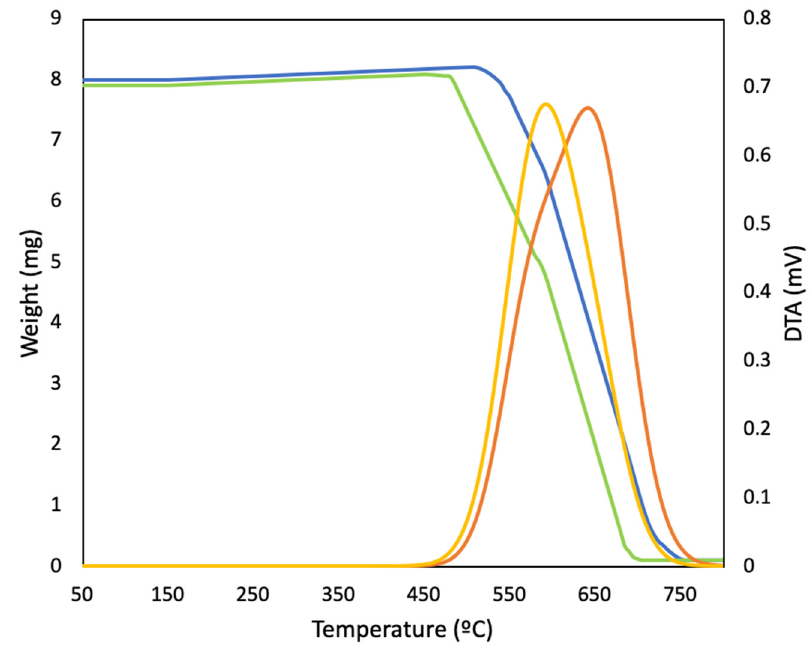
Figure 5. TG-DTA profiles of coke number 1 (red-blue) and coke number 2 (green-yellow). Table 3. Proposed additional characterisation of coke used for the manufacture of SiC and yield at both laboratory and industrial levels. OTI is the Optical Texture Index [46].